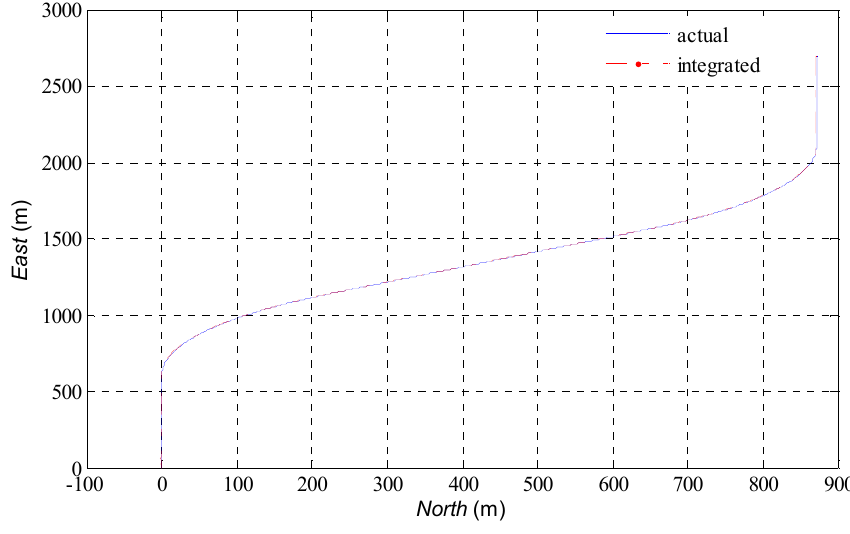
Figure 3. The trajectory of the USV.